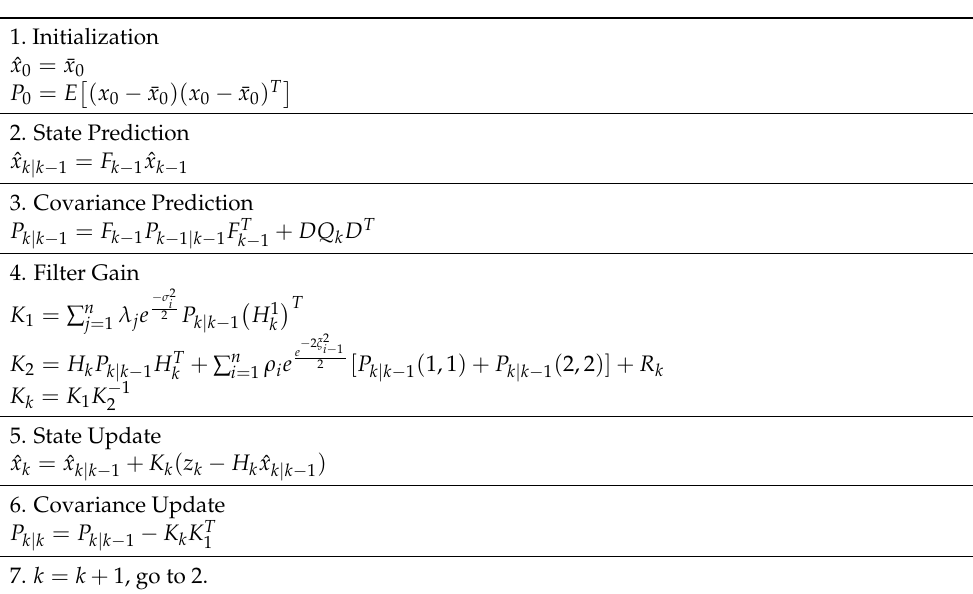
Table 1. PL-MMSE under Gaussian mixture